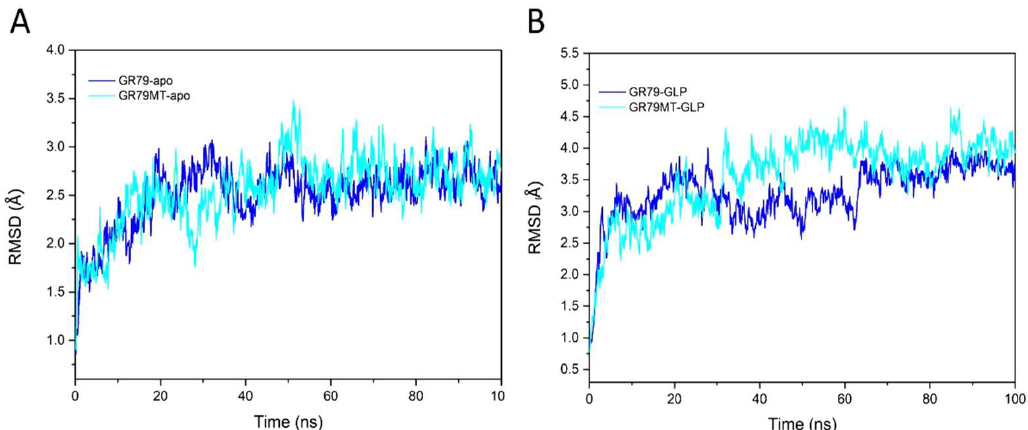
Figure 2. Molecular dynamics analysis diagram. ( A ) Molecular dynamics analysis of GR79-EPSPS and GR79(Y40I)-EPSPS without substrate (glyphosate); ( B ) molecular dynamics analysis of GR79- EPSPS and GR79(Y40I)-EPSPS combined with glyphosate. GR79-EPSPS is marked in dark blue, and GR79(Y40I)-EPSPS is marked in light blue.